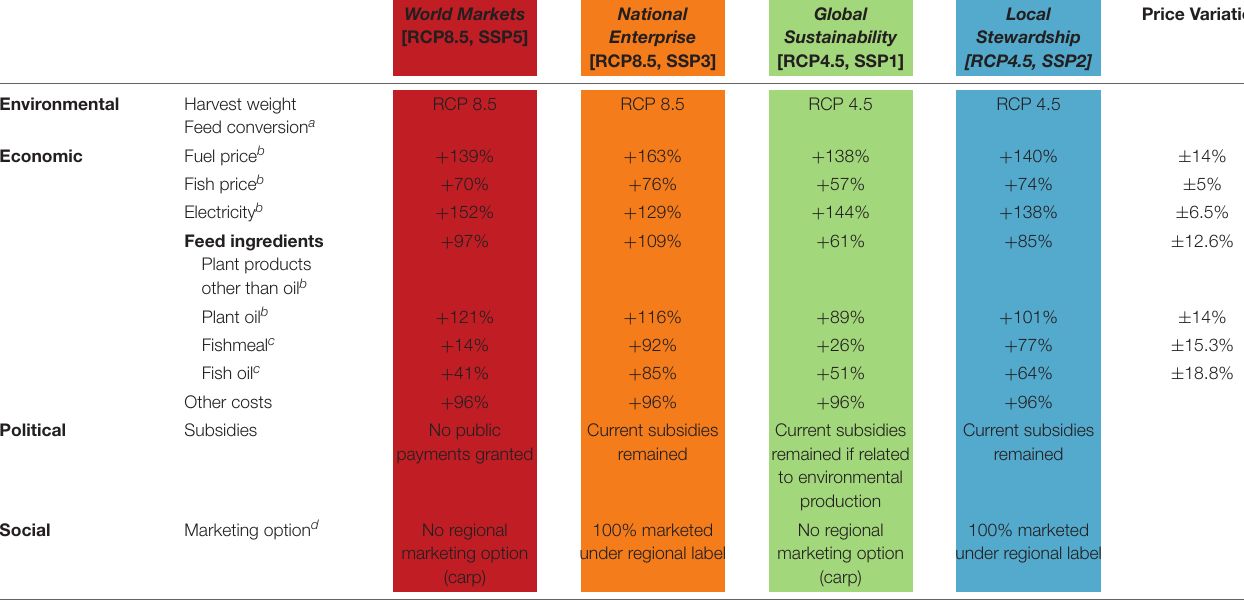
TABLE 1 | Summary of the variables applied within typical fish farms for the four climate change and European aquatic resources (CERES) scenarios: Overall future nominal price trends for fish, fuel, electricity, and fish feed ingredients are given for the year 2050 relative to